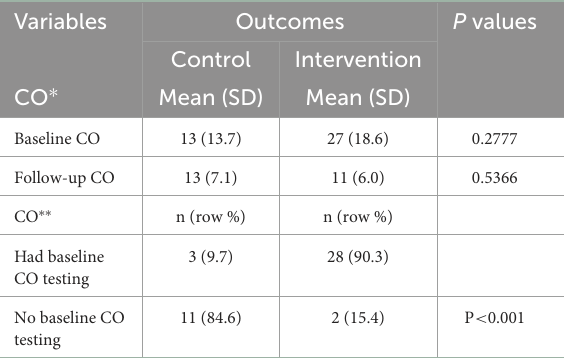
TABLE 4 Mean eCO levels at baseline and follow-up by intervention